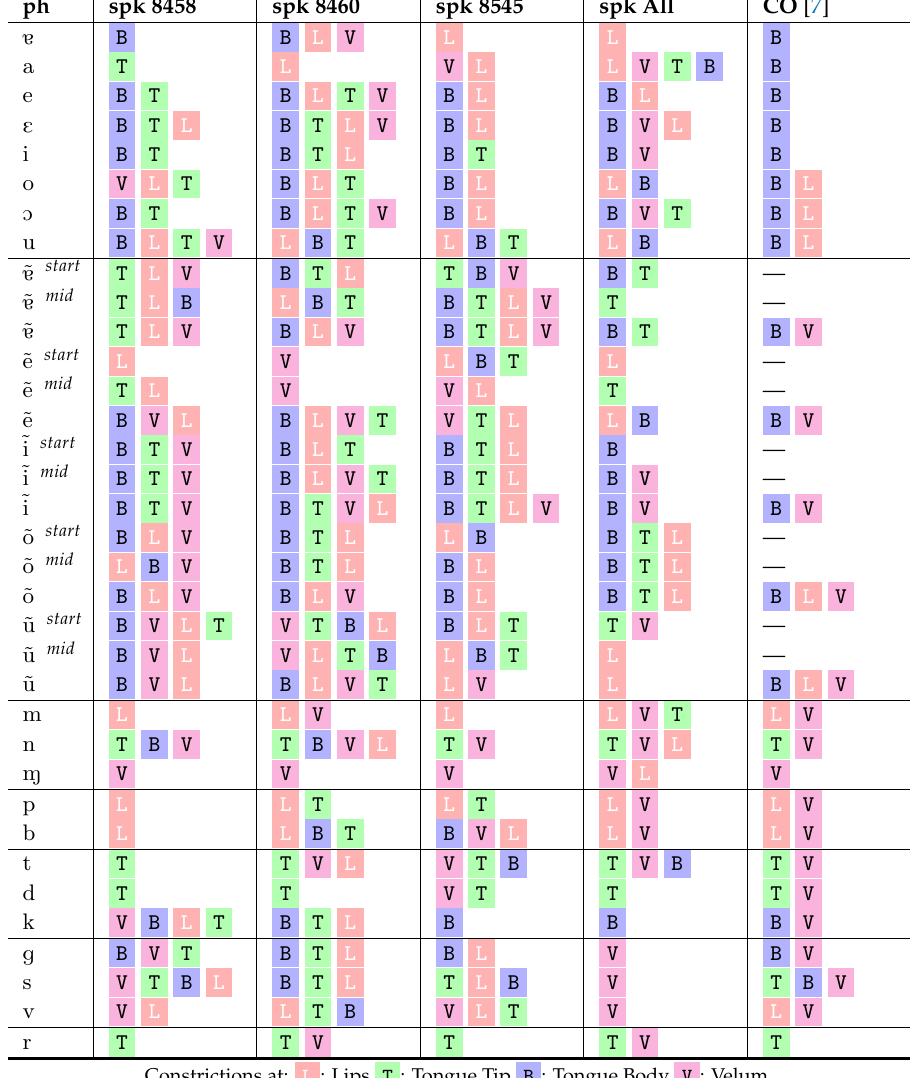
Table 5. Critical articulators for the different phones and speakers. Each tract variable is considered as an articulator (2D analysis). The order of the different articulators, for each phone, reflects their importance. The two rightmost columns present the determined critical articulators gathering the normalized data for all speakers (spk All) and a characterization of EP sounds based on the principle of Articulatory Phonology as found in Oliveira [7]. For the sake of space economy, in the tract variable listing the T and C were omitted, for example, TBC became